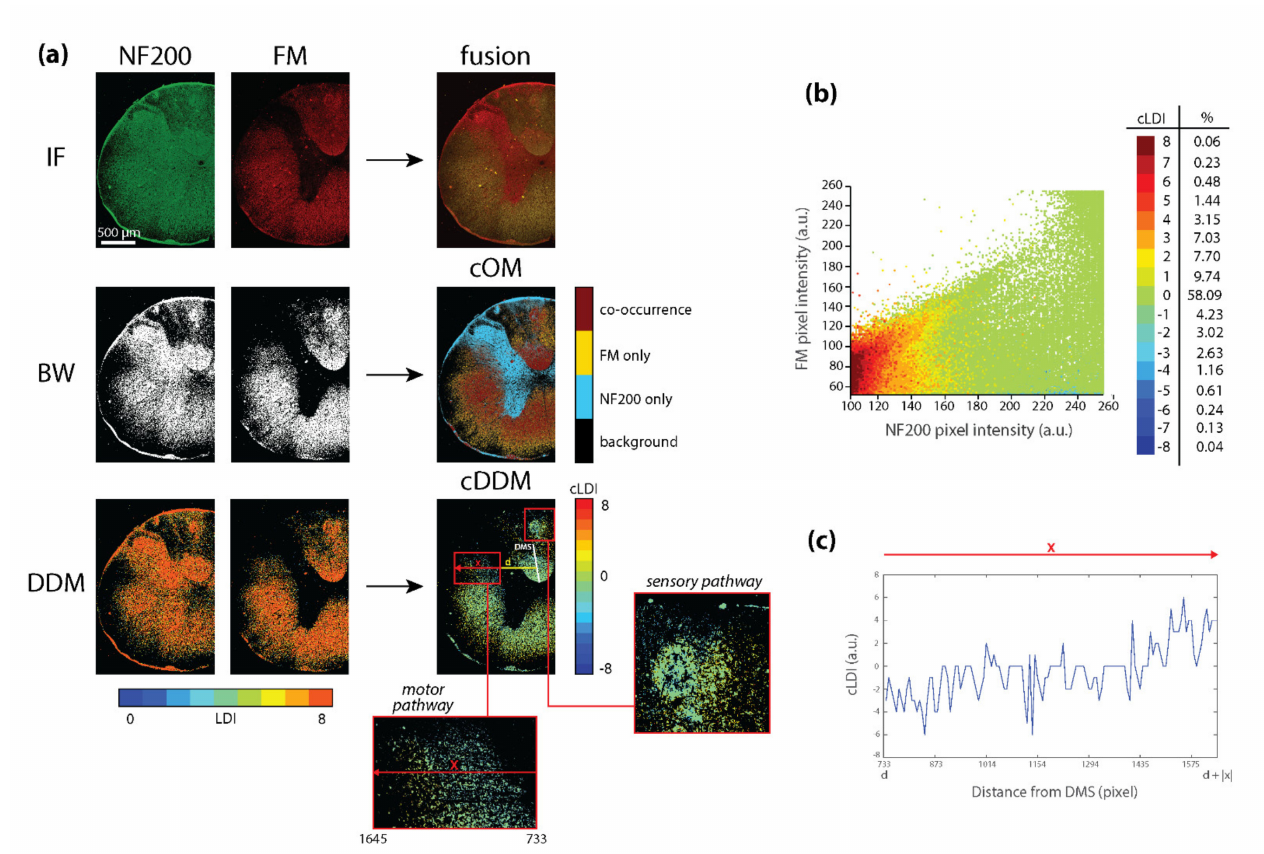
Figure 4. cDDM opens to the formulation of new biological considerations. ( a ) Top: Exemplificative immunofluorescence (IF) images of rats’ spinal cord, marked against the axonal (NF200), the myelin (FM) components of the cord, or both (fusion). Middle: NF200 and FM signal binary masks (BW), whose combination produce the co-occurrence map (cOM). Bottom: NF200 and FM DDMs and cDDM. ( b ) Scattergram of NF200 and FM signals intensity color-coded by cLDI, showing a clear prevalence of equi-density pixels (grey, cLDI = 0). ( c ) The line plot reports the cLDI values underlying the horizontal red arrow (x) inside the “motor pathway” magnification. The cLDI medio-lateral distribution is shown in function of the pixel distance (d, yellow line) from the dorsal median sulcus (DMS, white line), highlighting a progressive myelin thinning from spinal cord center to